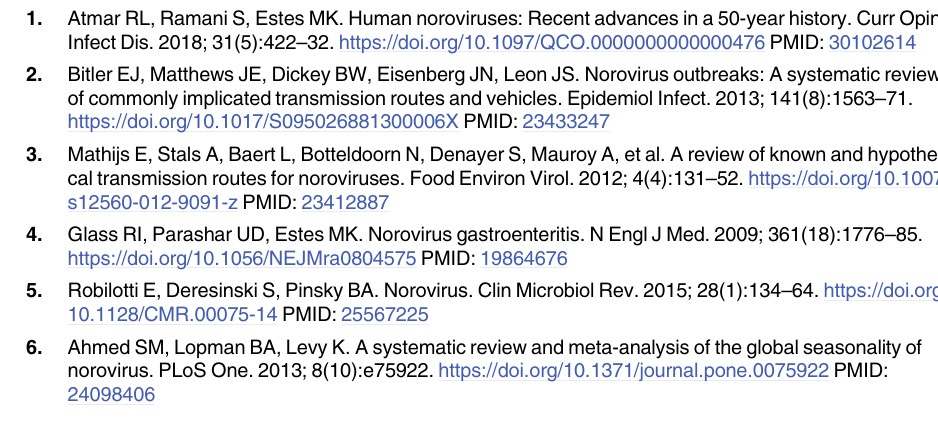
S4 Fig. (A) Comparison of GII.4 genome sequences detected from Family 14 in periods F10 and F11. (B) Comparison of GII.8 genome sequences detected from Family 14 in periods F10 and